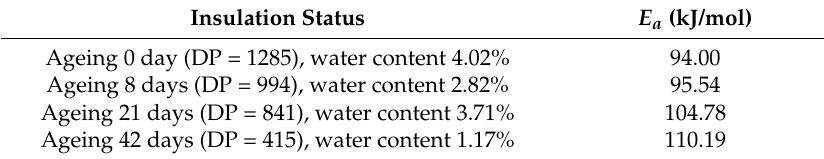
Table 2. Activation energy values of oil-impregnated pressboard specimens with various insulation statuses.